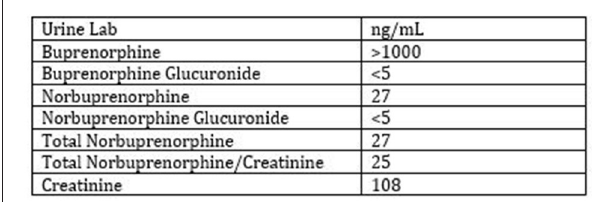
FIGURE 1 | Urine drug screen (USD)